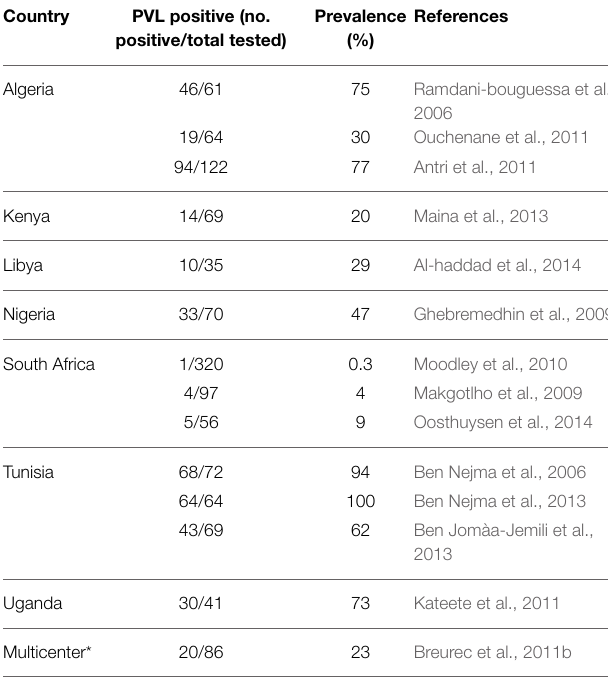
TABLE 3 | Panton-Valentine Leukocidin prevalence as reported by the eligible studies with sample size of 30 or above. Country